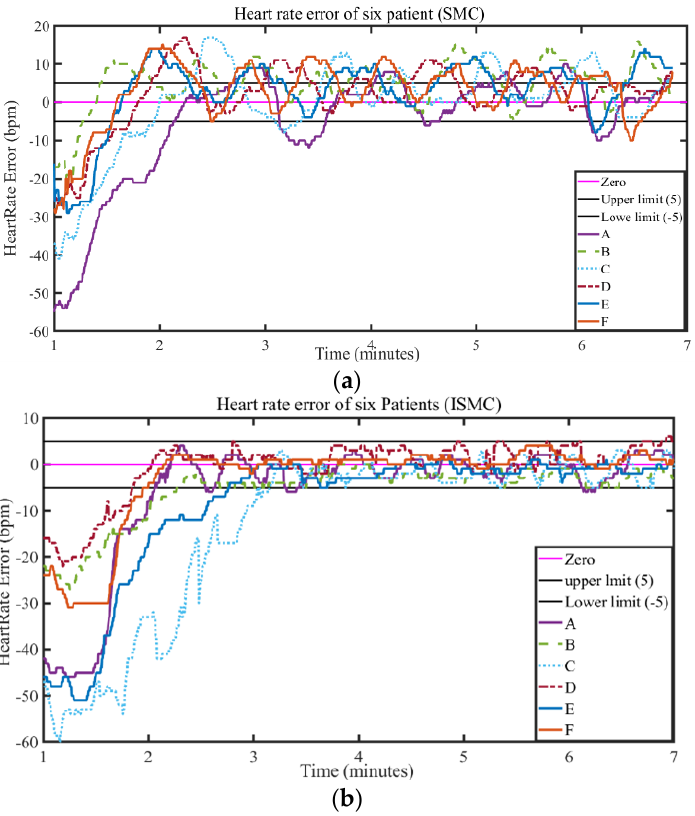
Figure 13. Heart rate tracking error of six subjects: ( a ) SMC, ( b ) ISMC.